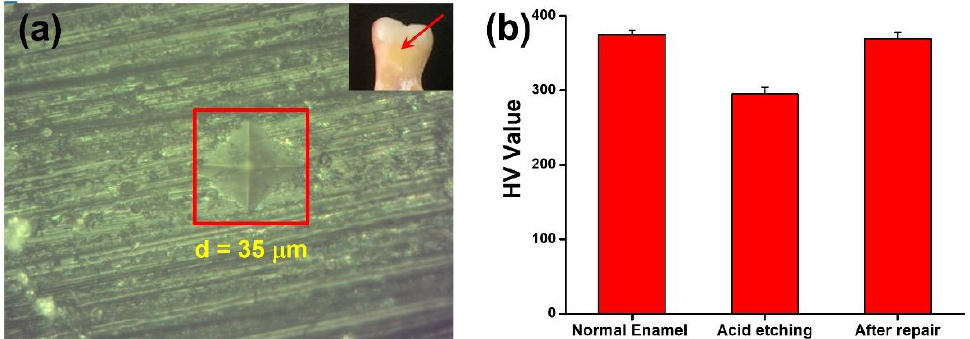
Figure 6. ( a ) Photo of indentation on the tooth enamel indicated by a red square. The length of indentation was 35 µ m. The inset indicates the location of indentation. ( b ) Vickers hardness values of normal tooth enamel, tooth enamel after acid etching for 10 min, and tooth enamel after acid etching and repair with CaP NCs. All data are reported as the mean ± standard deviation, with n = 5 per category.